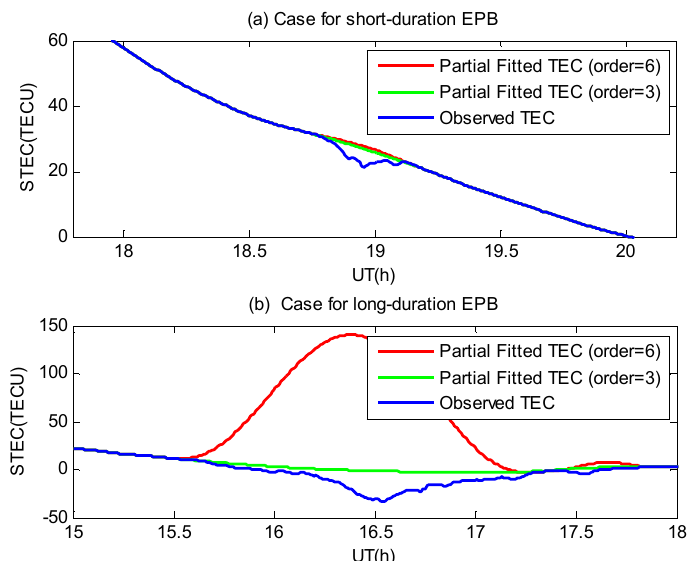
Figure 8. Above two cases with different polynomial orders. The blue line represents the observed TEC, the green and red lines present the partially fitted TEC using third-order and sixth-order polynomial, respectively. ( a ) Case for short-duration EPB; ( b ) case for long-duration EPB.